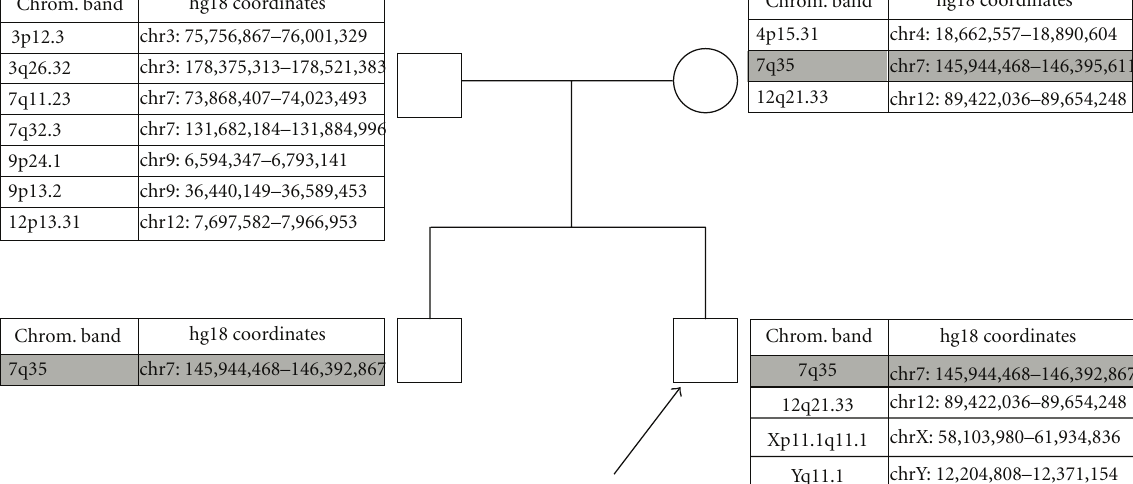
Chrom. band Chrom.